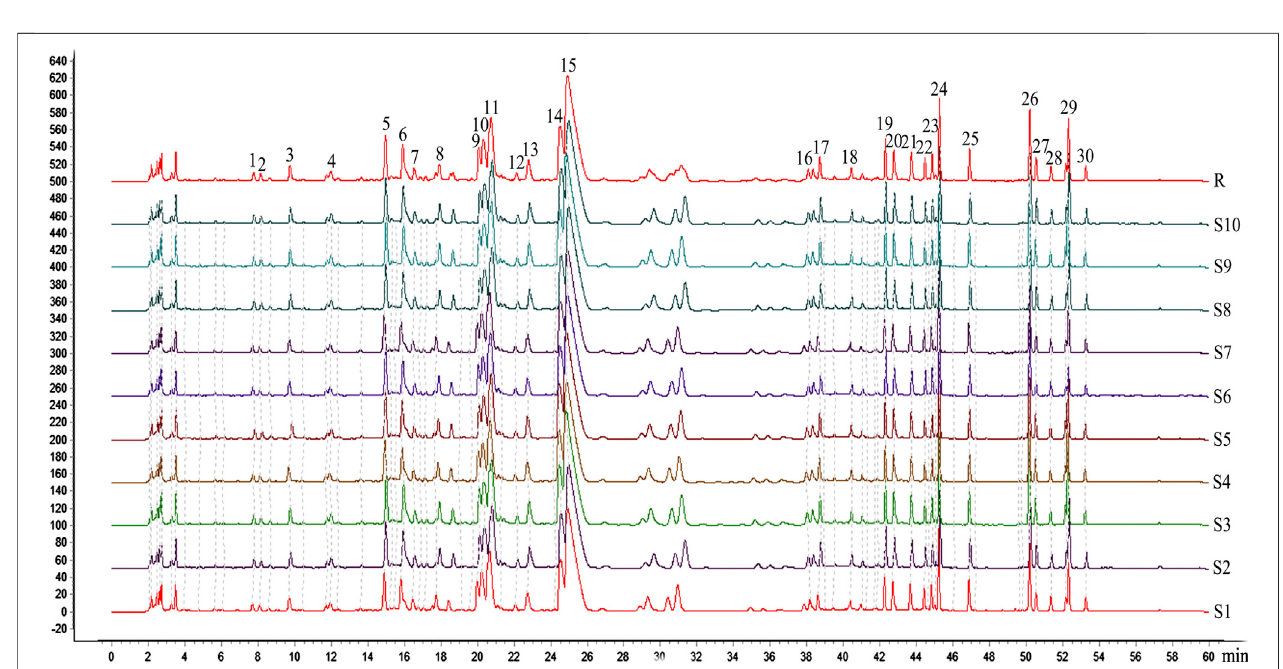
FIGURE 2 | The common pattern diagram of HPLC fi ngerprint chromatograms of extracts from Gandou Decoction (GDD).